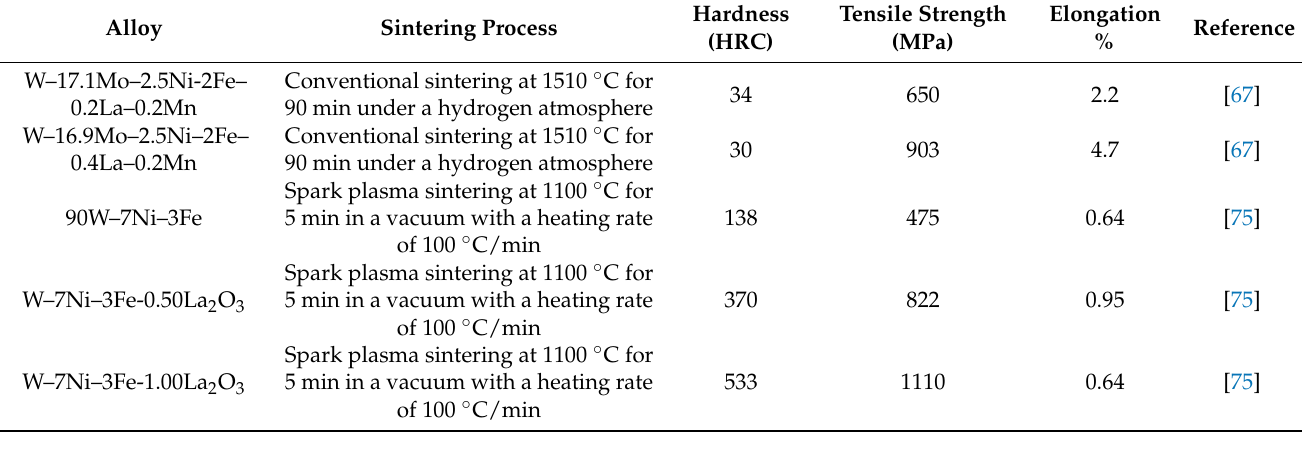
Table 4. Mechanical properties of W–Ni–Fe with lanthanum oxide.